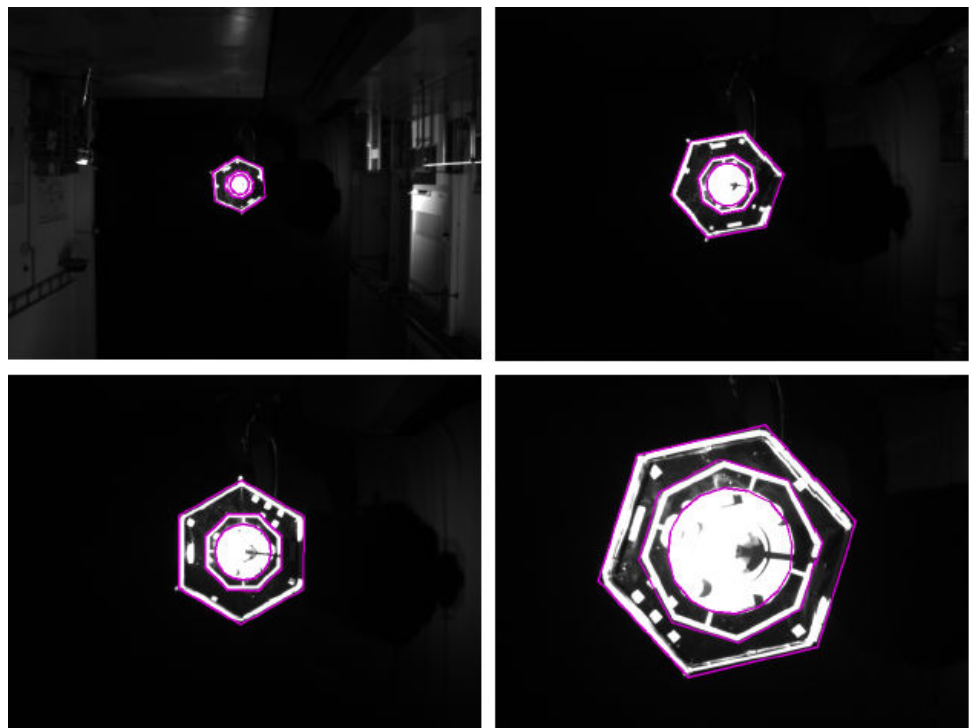
Figure 16. Images of the navigation camera at different distances with pose estimation result